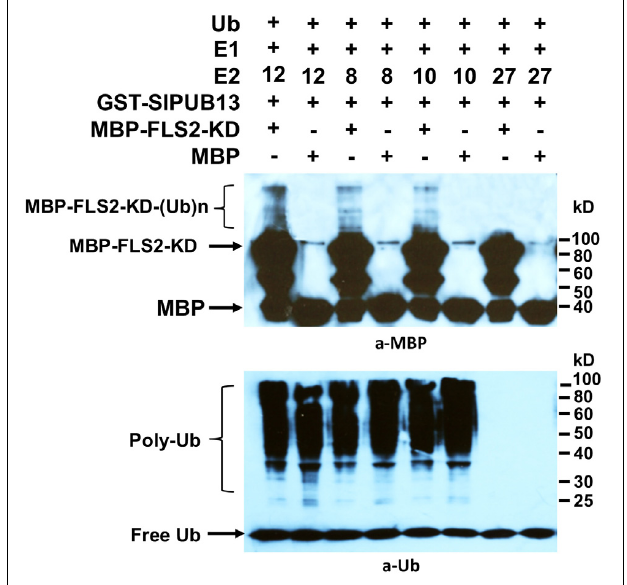
FIGURE 4 | Tomato PUB13 works with group III E2s to ubiquitinate FLS2-KD. FLS2-KD was ubiquitinated in the presence of GST-SlPUB13 and a member of group III E2 in in vitro ubiquitination assay. The assay was performed with recombinant E1, E2, GST-SlPUB13, ubiquitin (Ub), and MBP-FLS2-KD. Reactions with non-group III E2 UBC27 were used as control. The MBP protein was used as control for the substrate. This experiment was repeated two times with similar